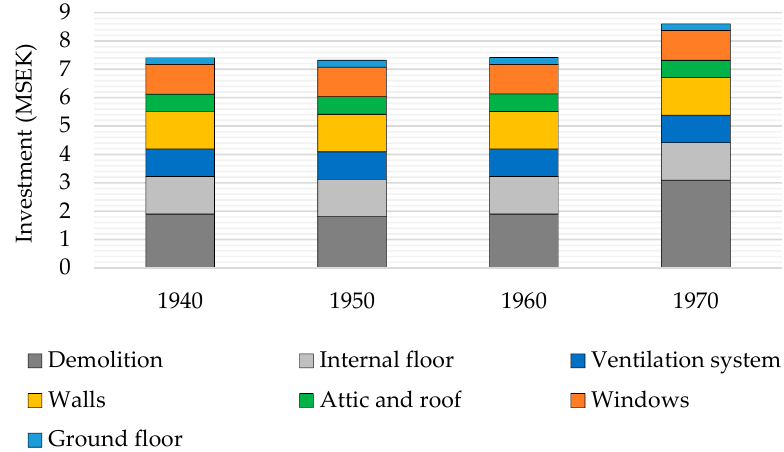
Figure 7. Investment cost of the demolition and construction of a building skeleton structure and ventilation system.